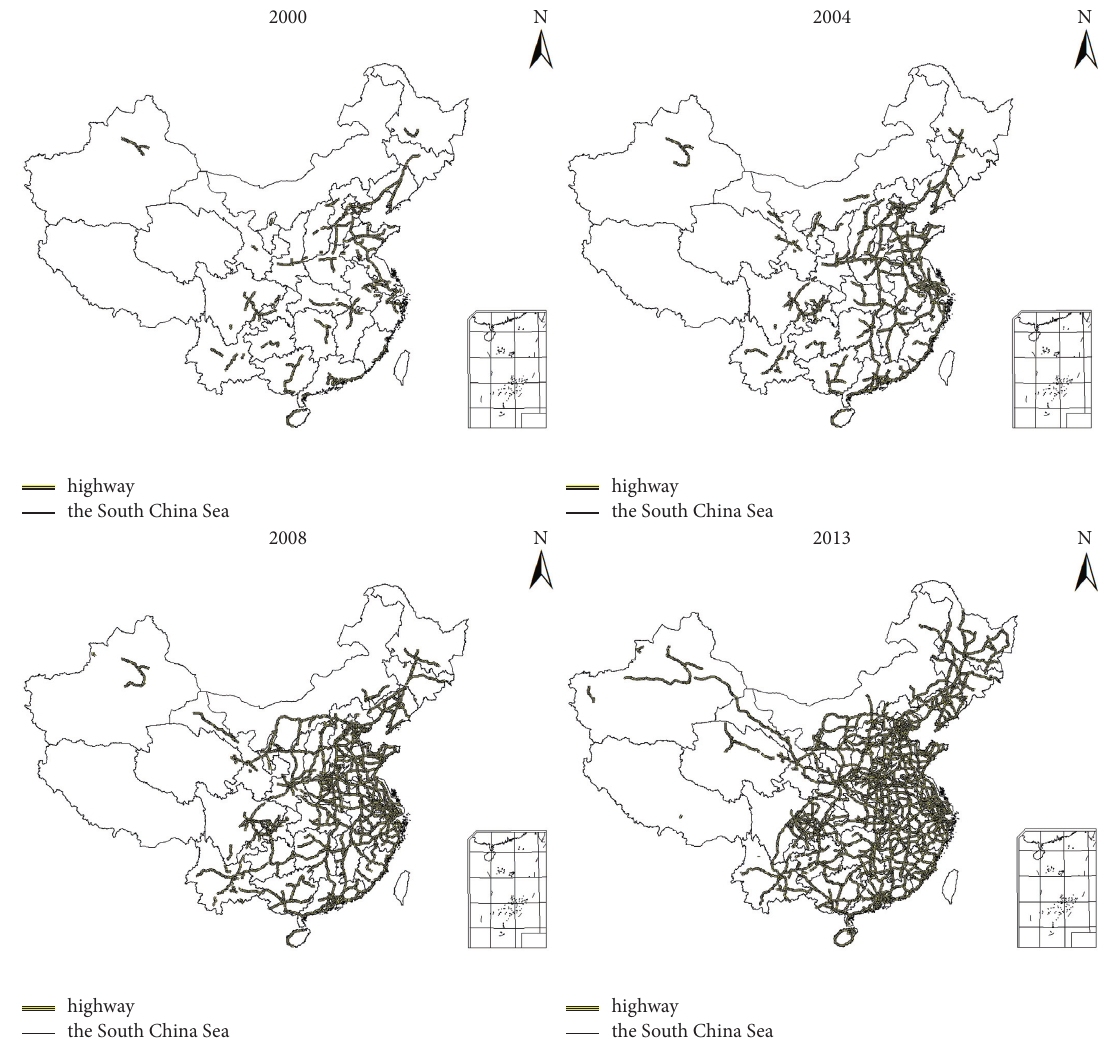
Figure 1: The highway layout of China in 2000, 2004, 2007, and